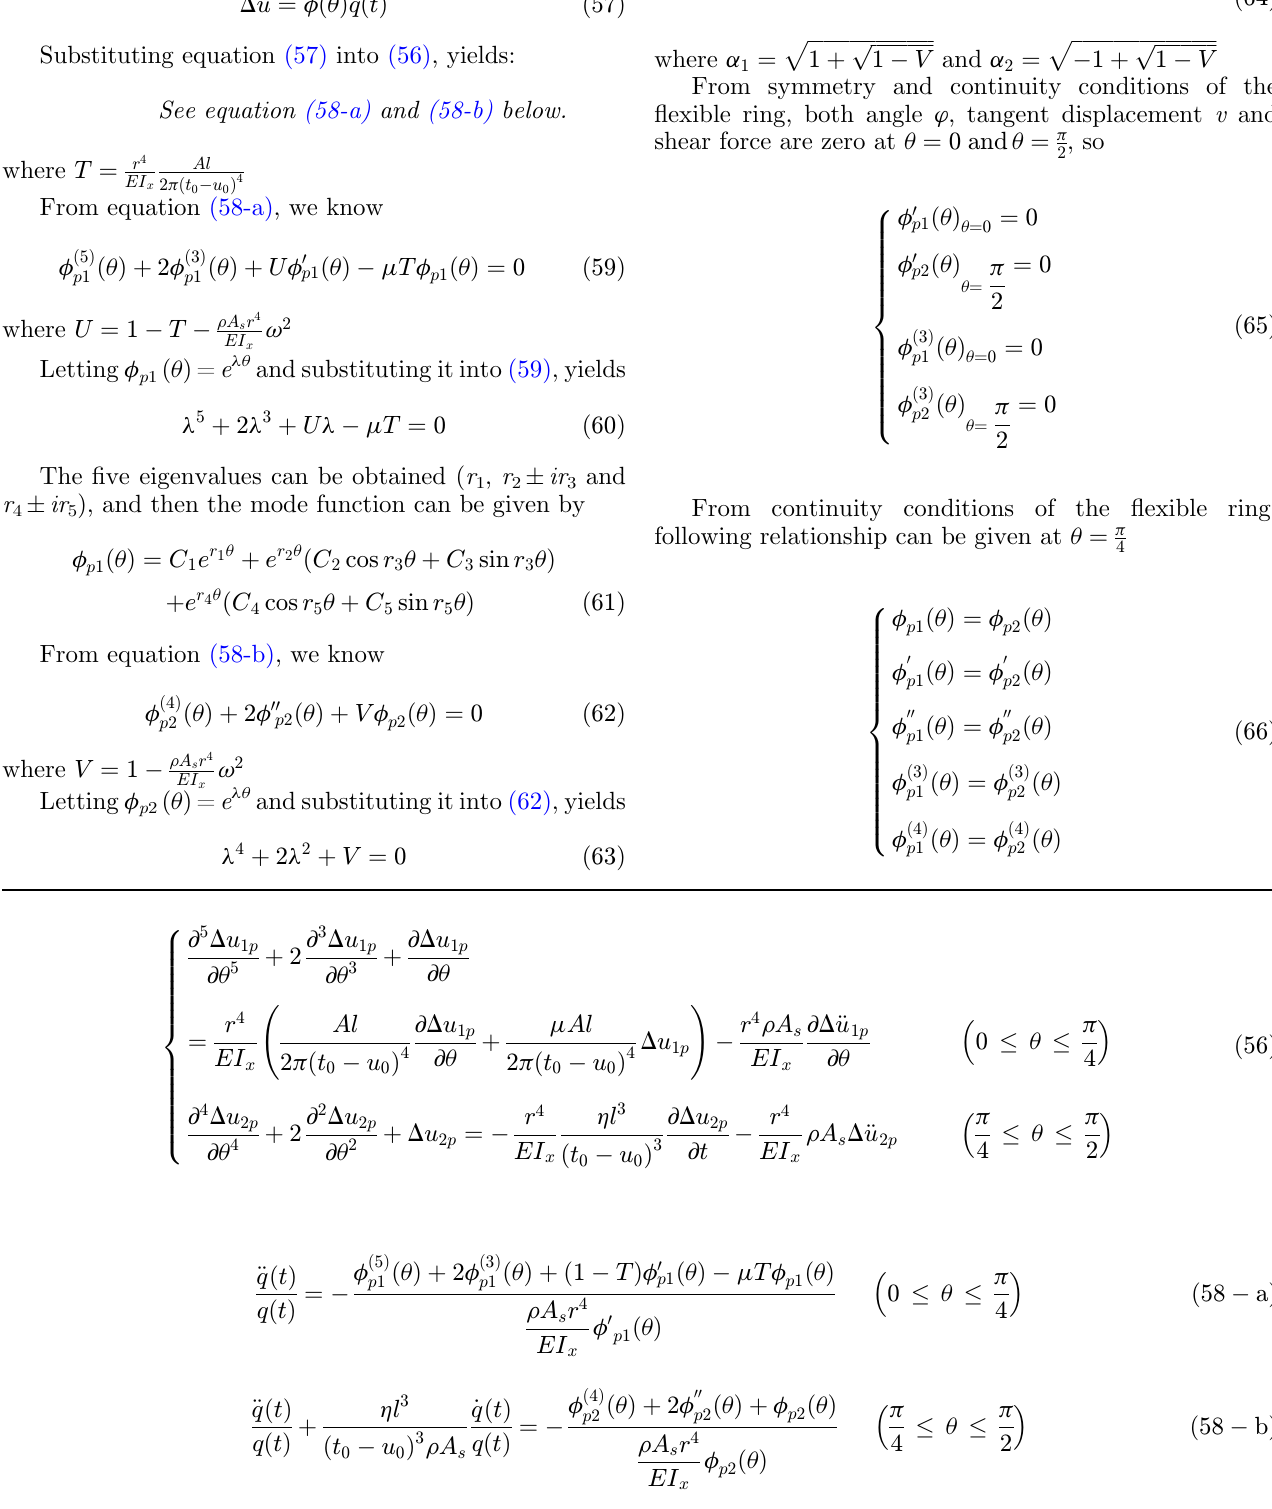
ffiffiffiffiffiffiffiffiffiffiffiffi p (cid:1) 1 þ 1 (cid:1) V